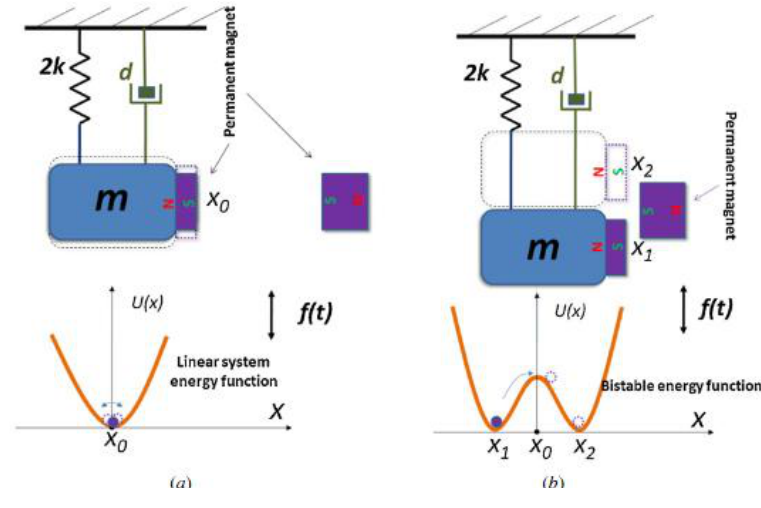
Figure 23. Comparison between linear and nonlinear oscillator with respect to potential energy function [96] ( © IOP Publishing. Reproduced by permission of IOP